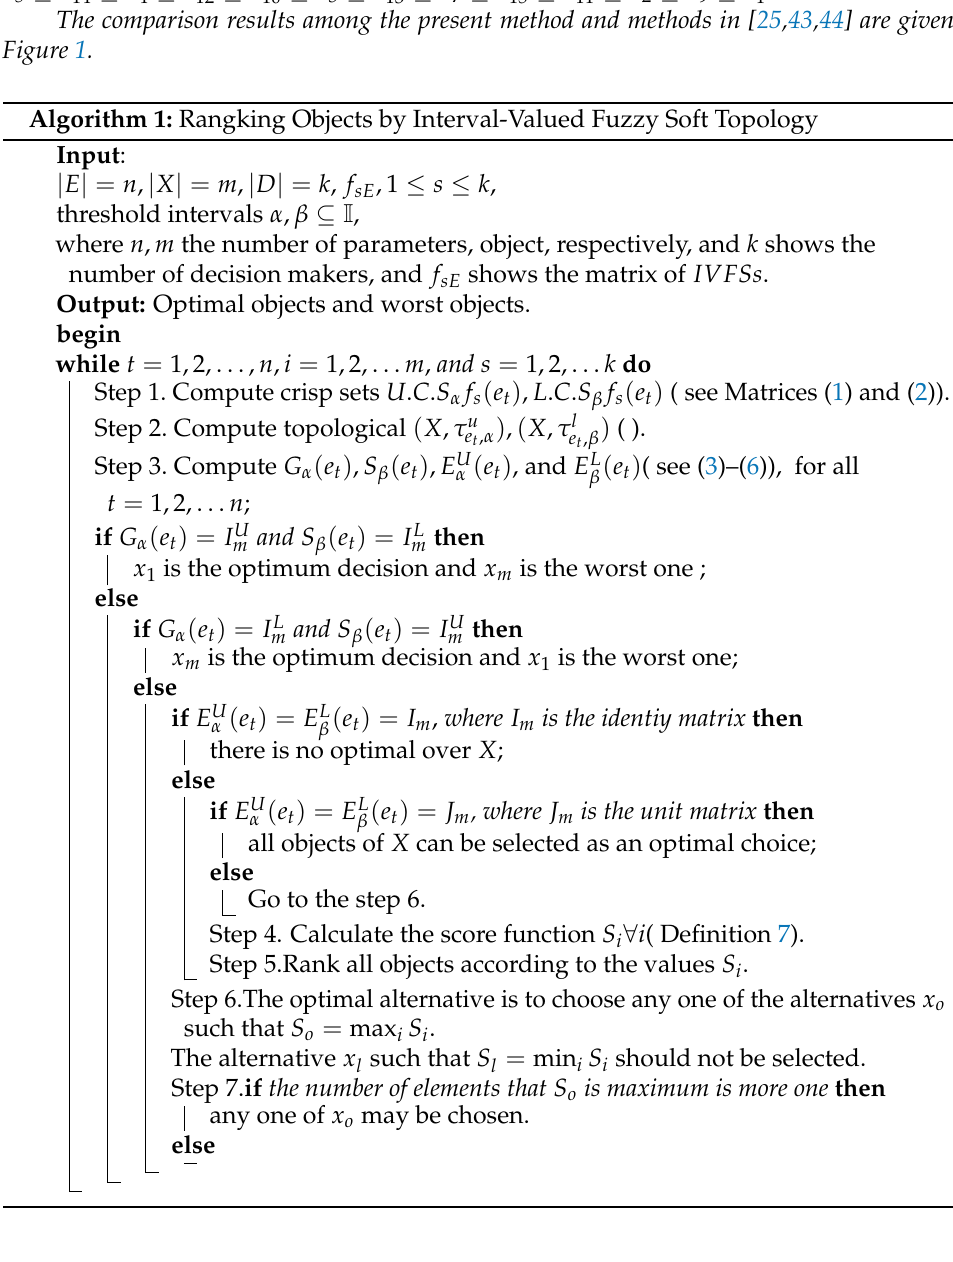
Figure 1. Algorithm 1: Rangking Objects by Interval-Valued Fuzzy Soft